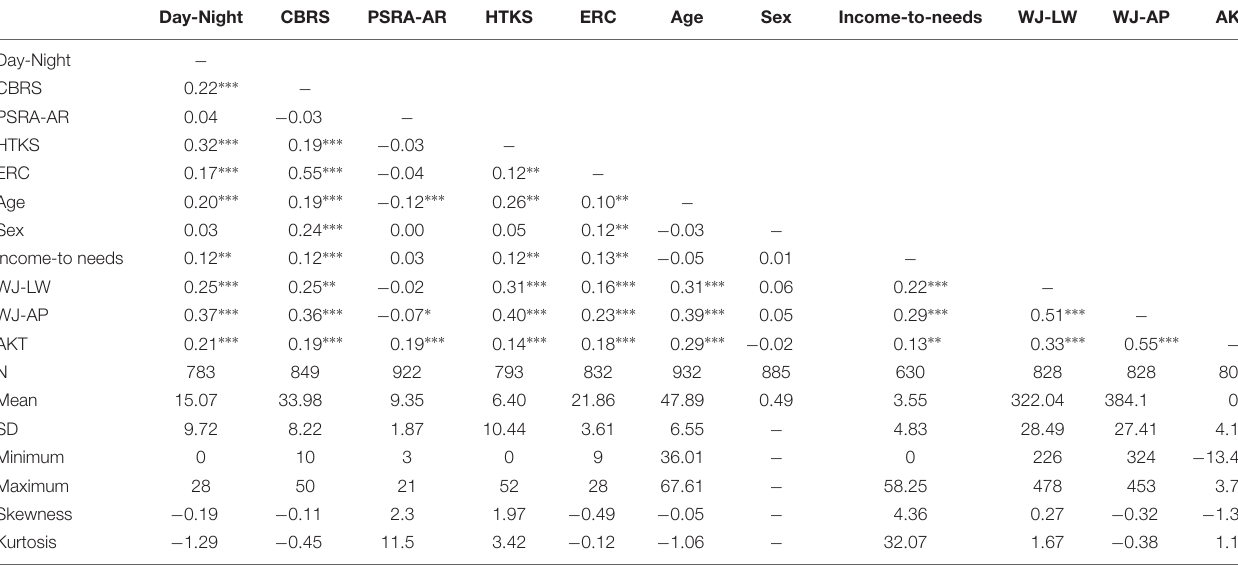
TABLE 1 | Descriptive statistics and correlations for study